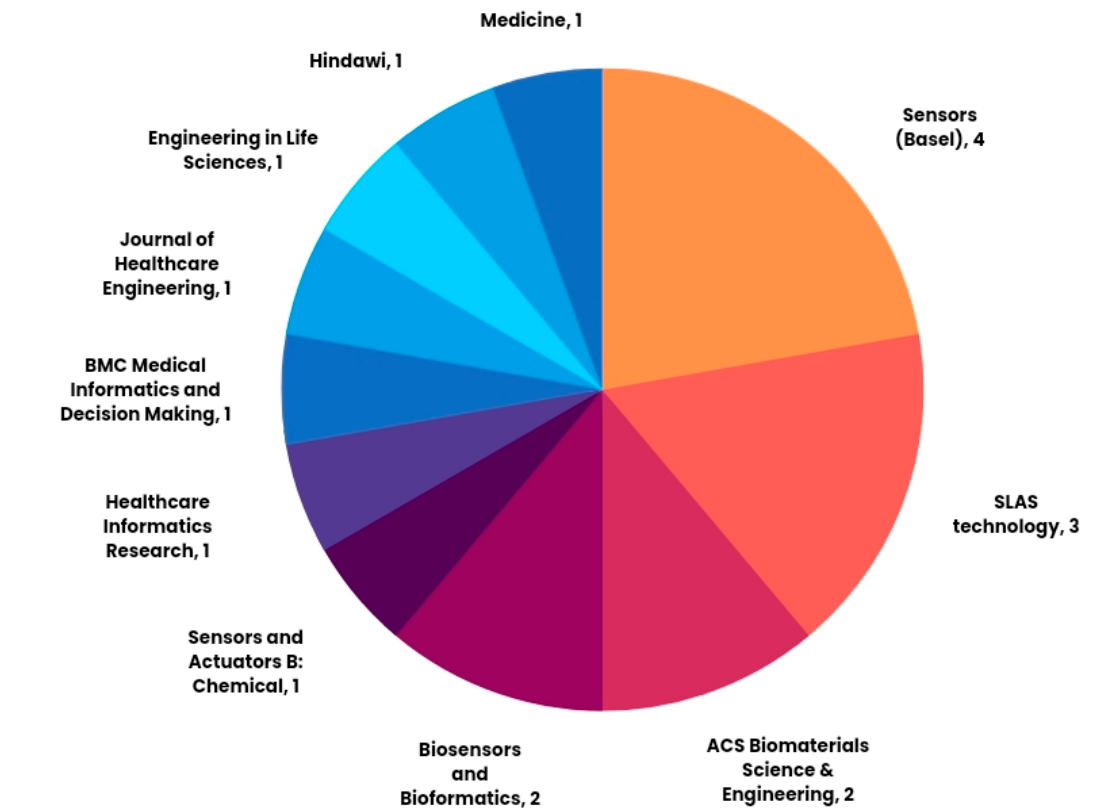
Figure 4. A pie chart of the number of investigations by journal name.